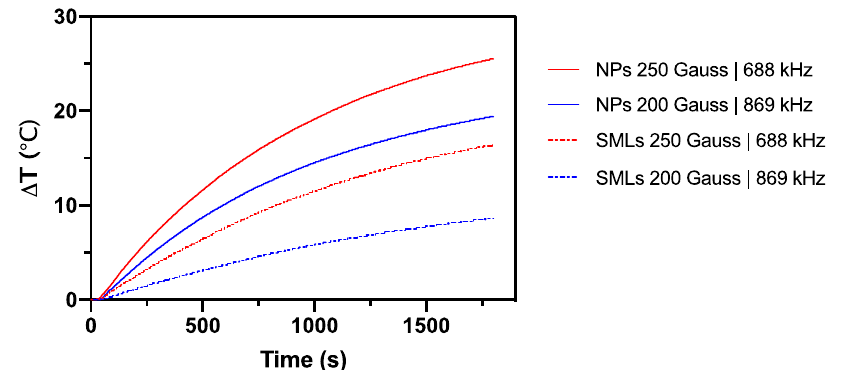
Figure 6. Magnetically-induced thermal response curve (temperature variation vs. time) of Ca 0.25 Mg 0.75 Fe 2 O 4 nanoparticles (NPs) and SMLs for magnetic hyperthermia. One mg of nanoparti- cles were dispersed in 1 mL of water and subjected to an AMF with different field frequencies and strengths, over 30 min (1800 s).